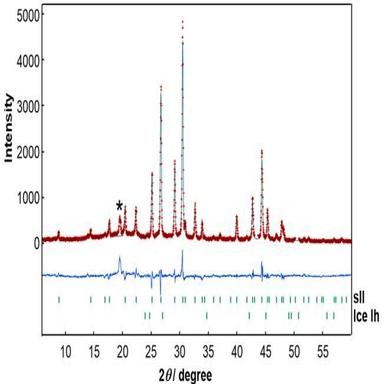
The PXRD pattern of the sII hydrate formed in H2 + CO2 + THP + water system. The measurement was performed at 153 K, and the resultant lattice parameter of the sII hydrate was 17.3075(8) Å. Red points and black line indicate diffracted pattern and calculated pattern, respectively. Blue line is a deviation between diffracted pattern and calculated pattern. The green tick marks in the lower part represent the calculated peak positions for the sII hydrate and hexagonal ice (Ih). Cupper peaks arising from the s